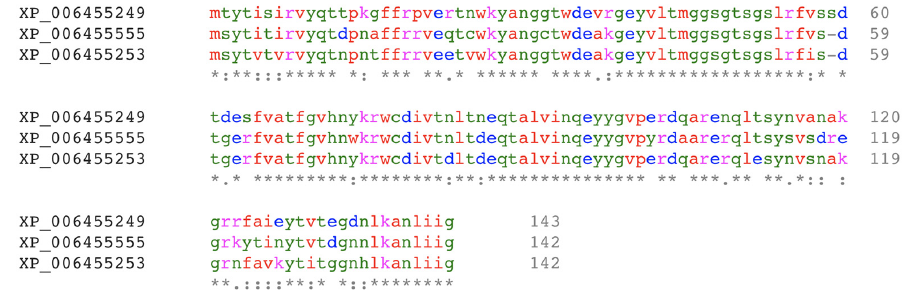
Figure 1. Alignment of amino acid sequences of A. bisporus lectin (ABL) (XP_006455249) and two of its closest putative lectin homologs in the A. bisporus U97 genomic library [27]. The protein annotations are according to the GenBank ID; the asterisk (*), colon (:), and period (.) signs indicate the identical, conserved, and similar amino acid residues, respectively.